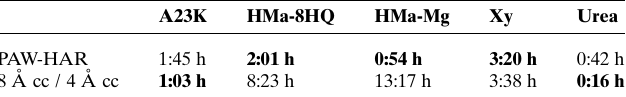
Table 1 Duration of calculations starting at the independent atom model. Reference system: Dell Precision 3640, Intel Core i9-10900K CPU, 32 GB RAM. Used cores: 10. The faster calculation is marked in bold font for each dataset.